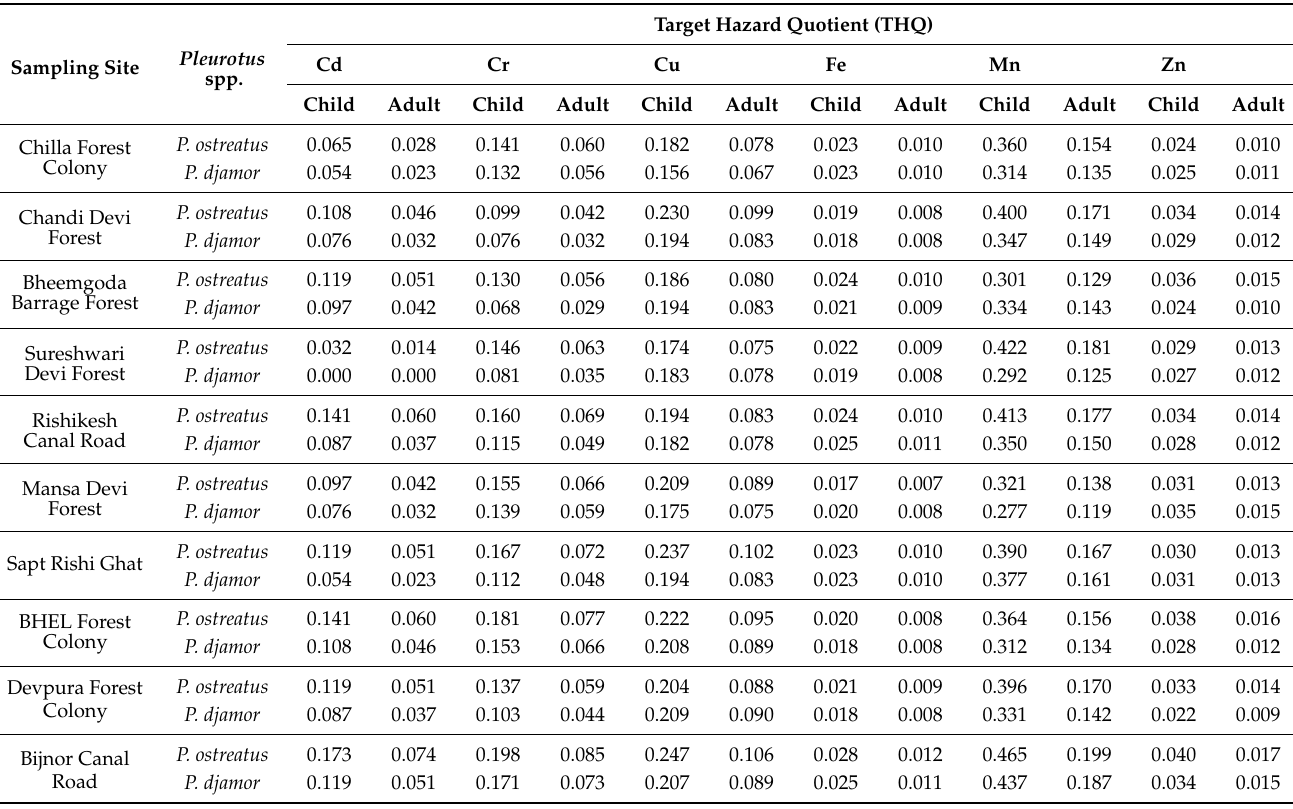
Table 3. Health risk index of heavy metal contents collected from different locations of Rajaji National Park, Haridwar, India.